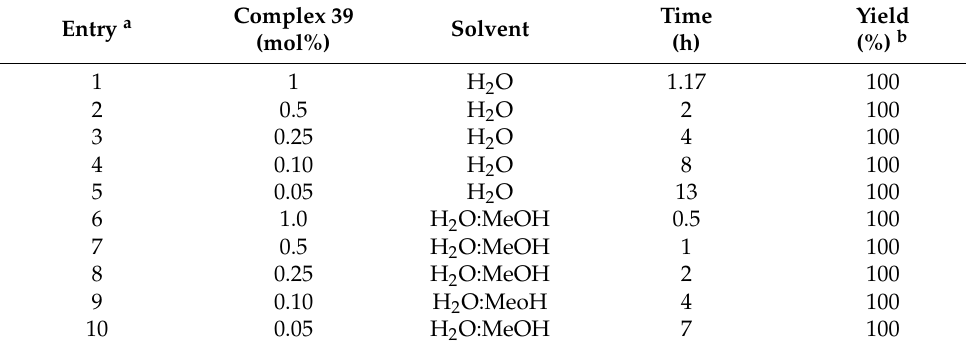
Table 15. Optimization of catalyst